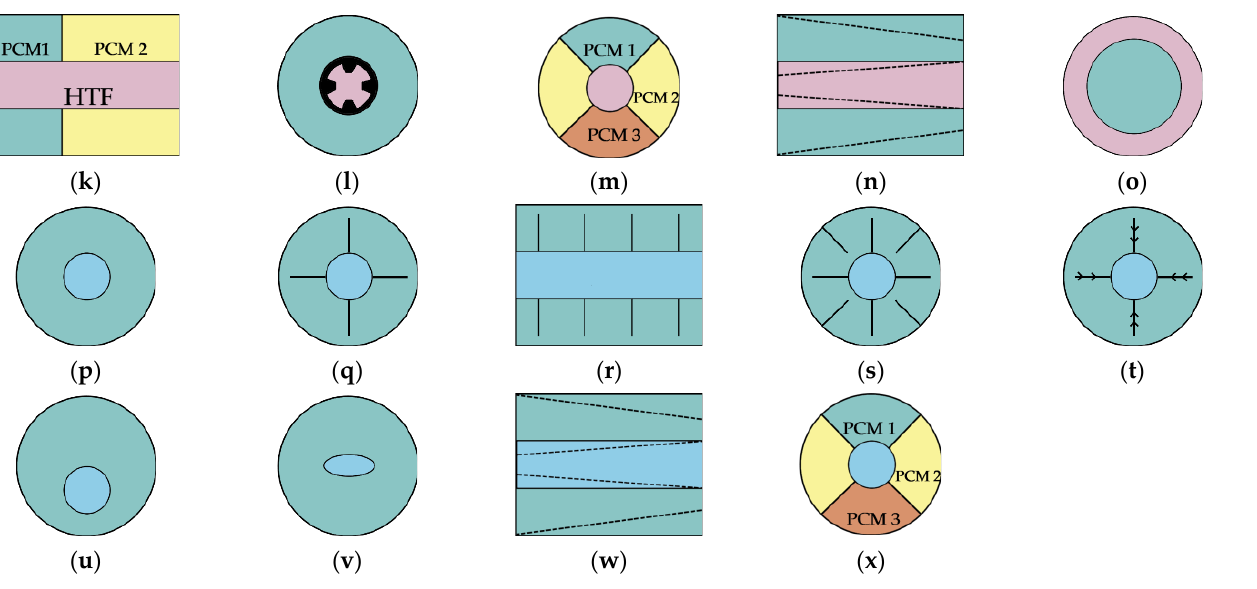
Figure 1. Horizontal double-tube arrangements; ( a ) Case DTH-M; ( b ) Case DTH-ILF-M; ( c ) Case